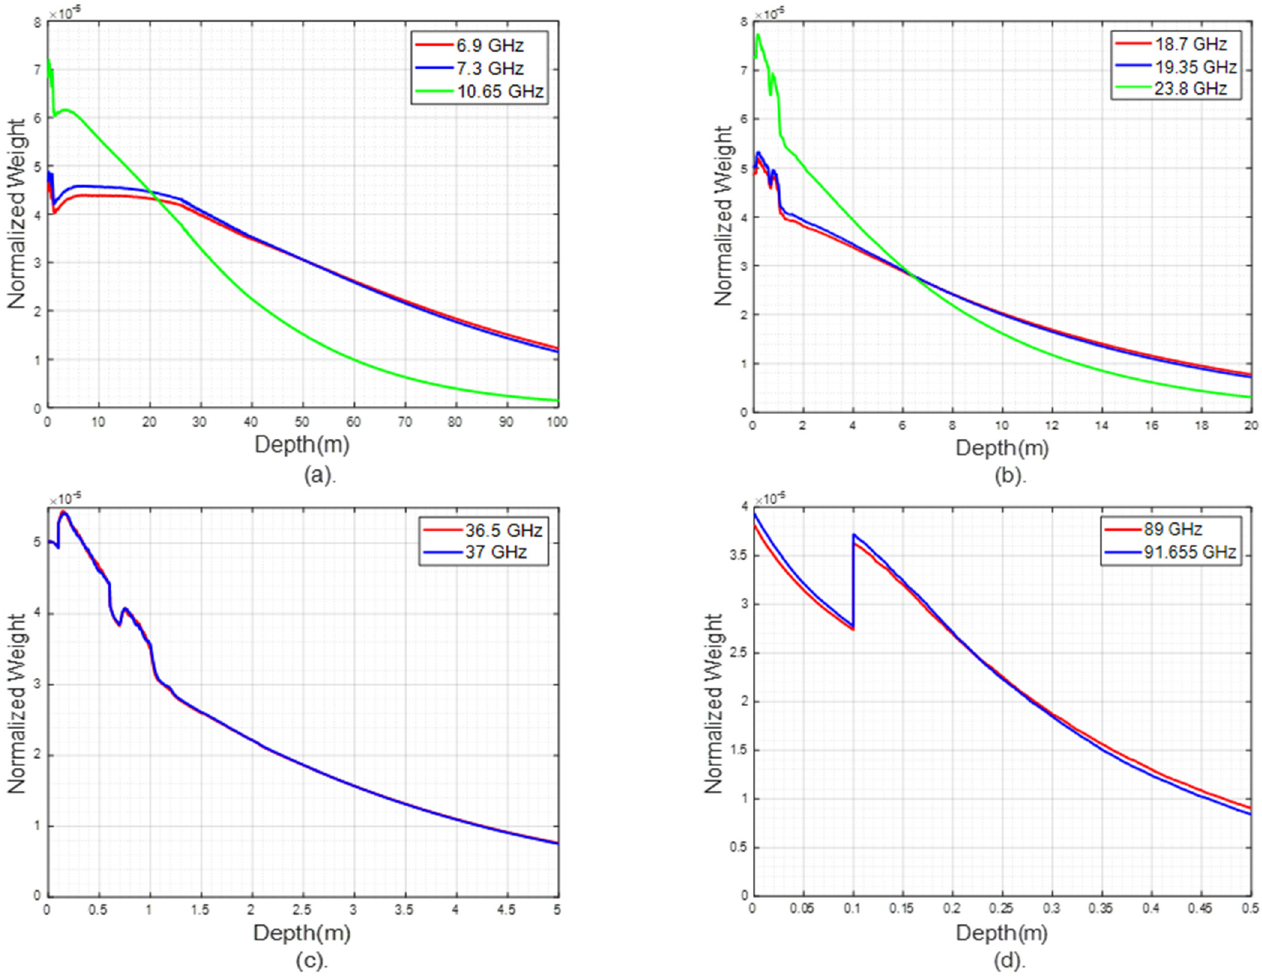
Figure 13. Normalized weight functions versus depth at frequencies ( a ) 6.9 GHz, 7.3 GHz, and 10.65 GHz; ( b ) 18.7 GHz, 19.35 GHz, and 23.8 GHz; ( c ) 36.5 GHz and 37 GHz; and ( d ) 89 GHz and 91.65 GHz. Note that these functions were calculated using the density and grain size profiles shown in Figure 12.